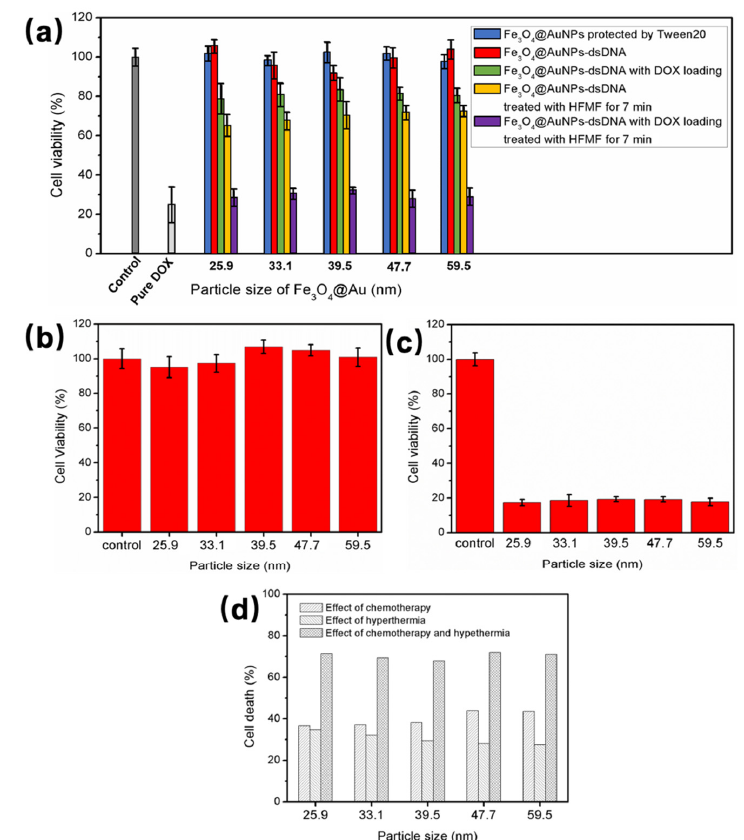
Figure 6. ( a ) HeLa cell viability after being treated with differently sized Fe 3 O 4 @Au NPs, Fe 3 O 4 @Au NPs conjugated with dsDNA, Fe 3 O 4 @Au NPs-dsDNA loaded with DOX, Fe 3 O 4 @Au NPs-dsDNA after treatment with HFMF, and Fe 3 O 4 @Au NPs-dsDNA loaded with DOX after treatment with HFMF. Cell viability of Fe 3 O 4 @Au NPs-dsDNA/DOX after targeting with aptamer and washing with PBS for ( b ) HeLa cells and ( c ) MCF-7 cells. ( d ) Effects of hyperthermia and chemotherapy on MCF- 7 cells. Except for lower DOX concentration, targeting the carrier to a specific cell is an effi- cient way to decrease side effects, and MCF-7, a targeted cell, was employed in this study. An aptamer sequence that had been demonstrated to have a specific binding ability with MCF-7 breast cancer cells was chosen [49], and HeLa cells were used as the control group, nanoparticles could be easily washed off by PBS. There was a notable distinction between the HeLa and MCF-7 cells after HFMF treatment; for the HeLa cells, cell viability remained greater than 95% among all DOX molecule carriers (Fe 3 O 4 @Au NPs-dsDNA/DOX) of dif- ferent sizes (Figure 6b). In contrast, the cell viability for MCF-7 cells decreased due to the effects of hyperthermia and chemotherapy (Figure 6c,d). Moreover, the IC50 was also texted based on these two cell lines (Table S1). The best particle size for future applications